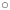
Evolution of the percentage of S. enterica cells that developed polar chemoreceptor clusters after cessation of SOS response induction in a culture growing in liquid medium.Cultures treated for 300 min with either 0.08 (○) or 10 (△) μg mitomycin C/mL were centrifuged to remove the inducer. Samples were periodically taken thereafter and the presence of polar clusters was determined. As controls, a non-treated culture (□) and two cultures treated again after centrifugation with either 0.08 (●, discontinuous line) or 10 (▲, discontinuous line) μg mitomycin C/mL are also shown. The results are the mean of three independent imaging experiments. Error bars represent the standard deviation.